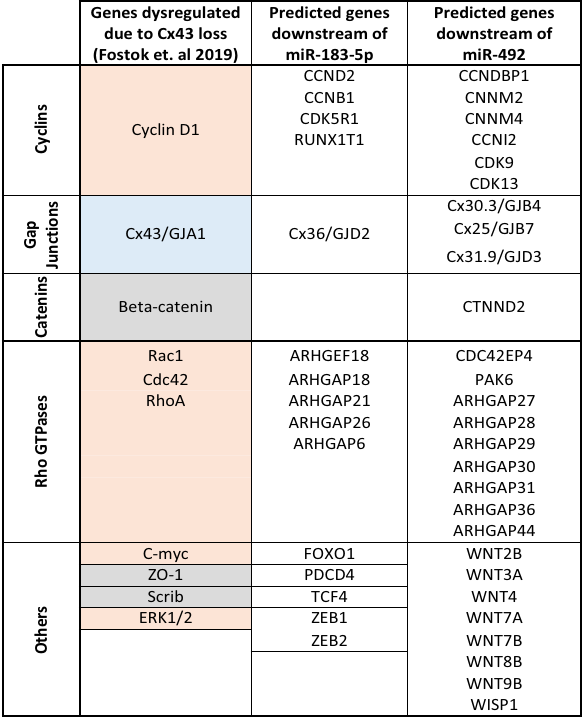
were observed previously upon silencing Cx43 in S1 cells 29,30 . For instance, miR-183-S1 and miR-492-S1 cells exhibited multi-layering and formation of larger acini in 3D cultures devoid of lumen, with disrupted epithelial polarity observed via the alteration of ß-catenin’s apico-lateral distribution, alteration of Cx43’s apical distribu- tion, loss/mis-localization of Scrib’s apico-lateral expression, and with decreased nuclear circularity. miR-183-5p and miR-492 over-expression triggered enhanced proliferation in cells cultured in both 2D and 3D conditions as well as enhanced invasion capacity when cultured under conditions with permissive or reduced ECM stiff- ness. Thus, miR-183-5p or miR-492 over-expression in the polarized S1 cells recapitulated the pretumorigenic phenotypic changes that were previously observed upon silencing Cx43 in S1 cells 29,30 . miR‑183‑5p and miR‑492 act as oncomiRs. To understand the potential mechanism of action of miR- 183-5p in breast cancer, IPA was used and revealed that the experimentally validated and predicted mRNA target(s) downstream of miR-183-5p in breast cells and tissues were (1) PDCD4, FOXO1 and BTRC (involved in invasion and proliferation pathways) and (2) MMP9, NFKB1, PTEN, SMAD4, TCF4, WNT2B, WNT5A and ZEB-1 (involved in epithelial polarity pathways). Cheng et al. showed that miR-183-5p expression level were significantly up-regulated in breast cancer patient samples as compared to normal adjacent tissues 43 .